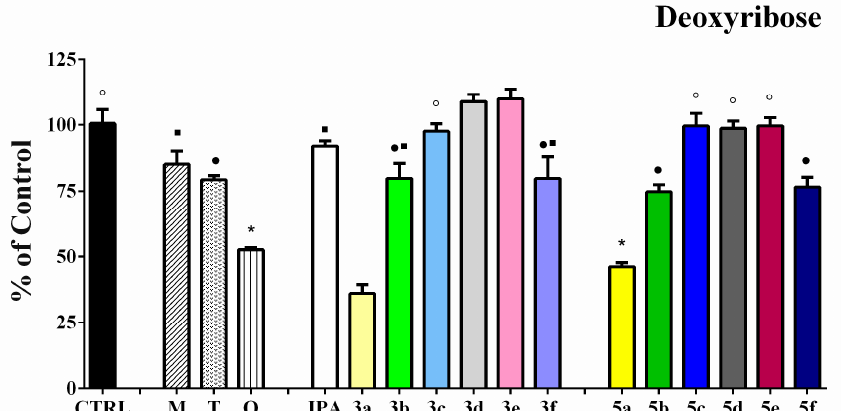
Figure 5. E ff ect of the tested hydrazones derivatives (80 µM) on the in vitro Fe(II)-induced degradation of 2-deoxyribose (0.5 mM). Data concerning the e ff ect of the used references melatonin (M), Trolox (T) and quercetin (Q) were presented. Data are presented as means ± SEM from three independent experiments. The e ff ect of compounds labeled with ∎ is considered statistically identical to the e ff ect of melatonin. Respectively, ◦ , ● and * label the compounds with an e ff ect statistically identical to Control, Trolox and quercetin.